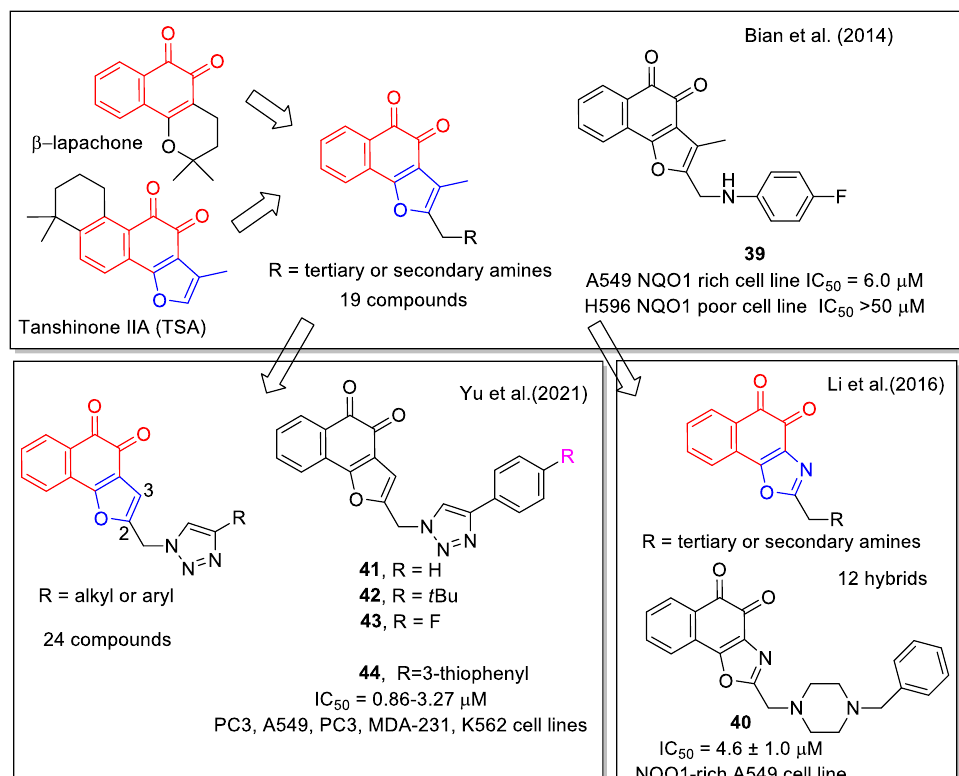
Figure 18. 1,2-Naphthoquinone hybrids with 2-functionalized furan as reported by Bian et al. [53] and with 2-amino oxazole by Li et al. [54], and by Yu et al.